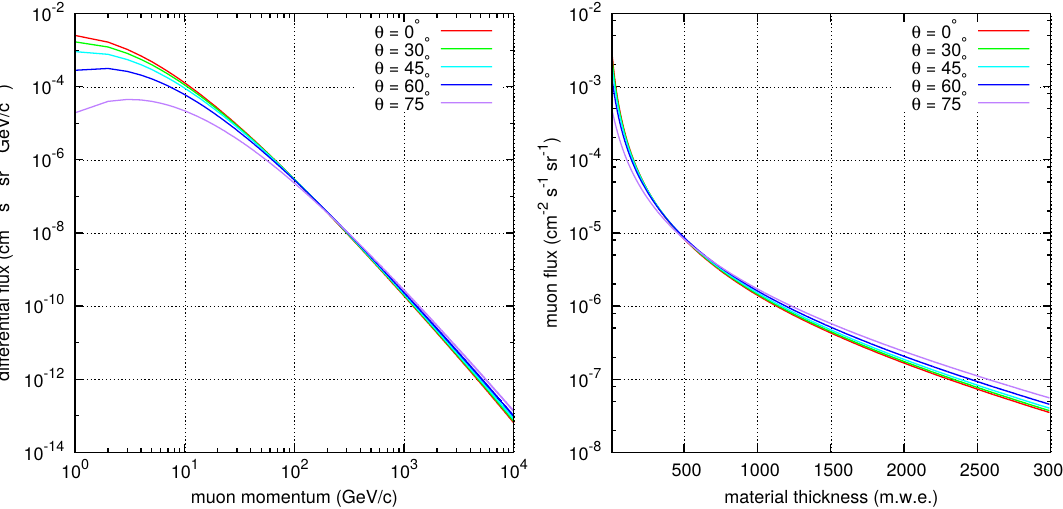
Figure 2. Energy spectrum of cosmic-ray muons for several zenith angles ( left ). Attenuation curve of the muon flux after passing through the “standard rock” ( right